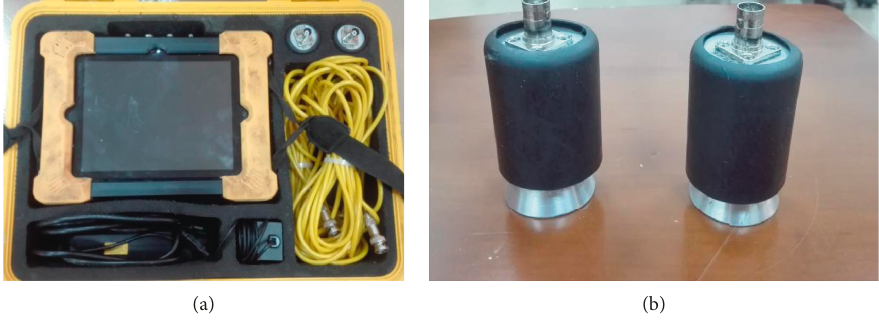
Figure 4: (a) ZBL-U520 host; (b) ultrasonic transmitter.